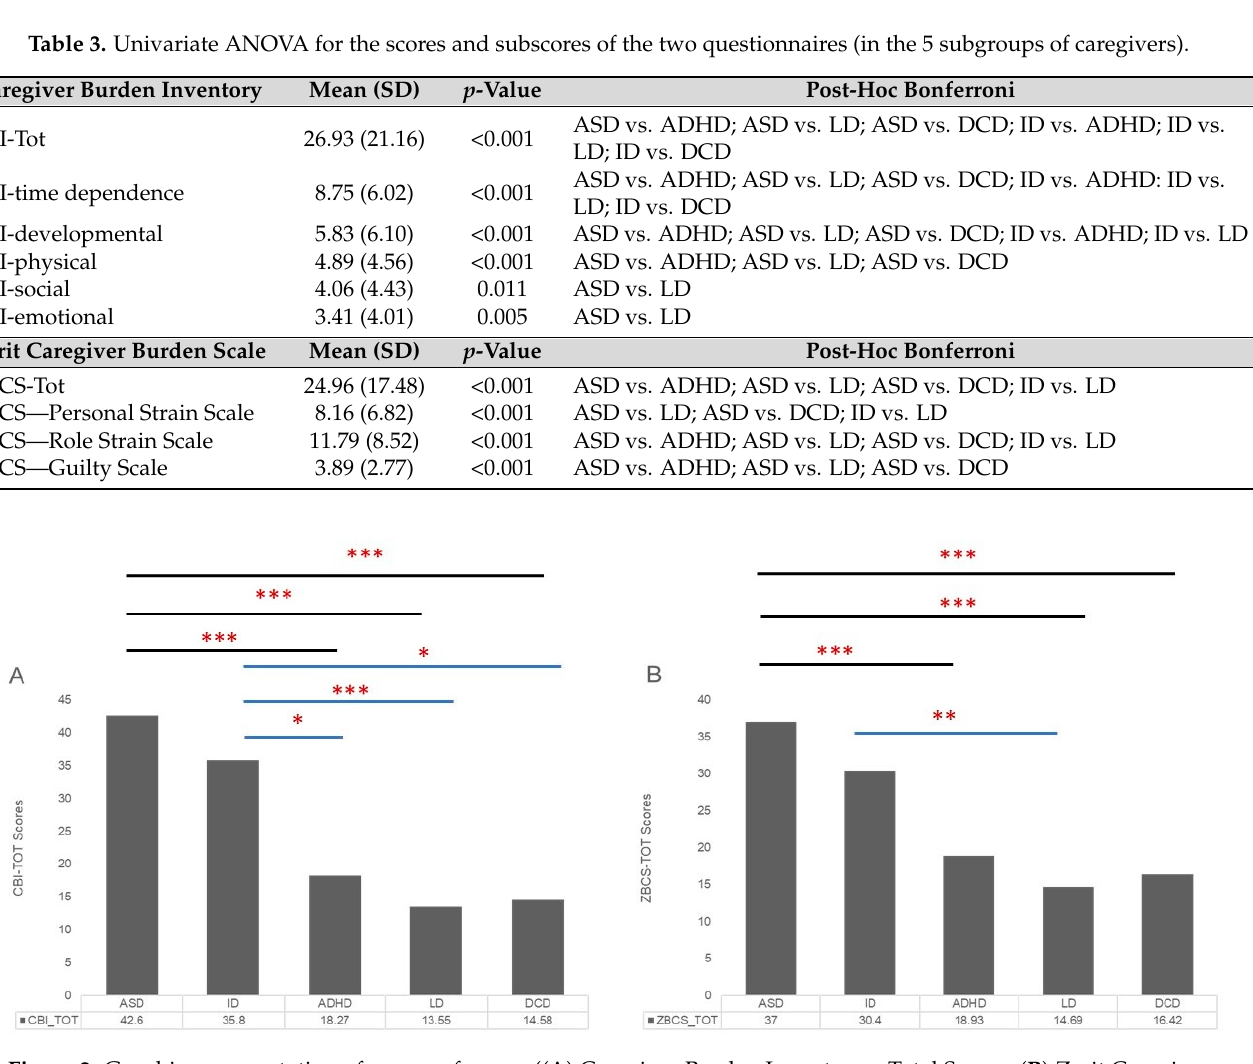
Table 3. Univariate ANOVA for the scores and subscores of the two questionnaires (in the 5 subgroups of caregivers).